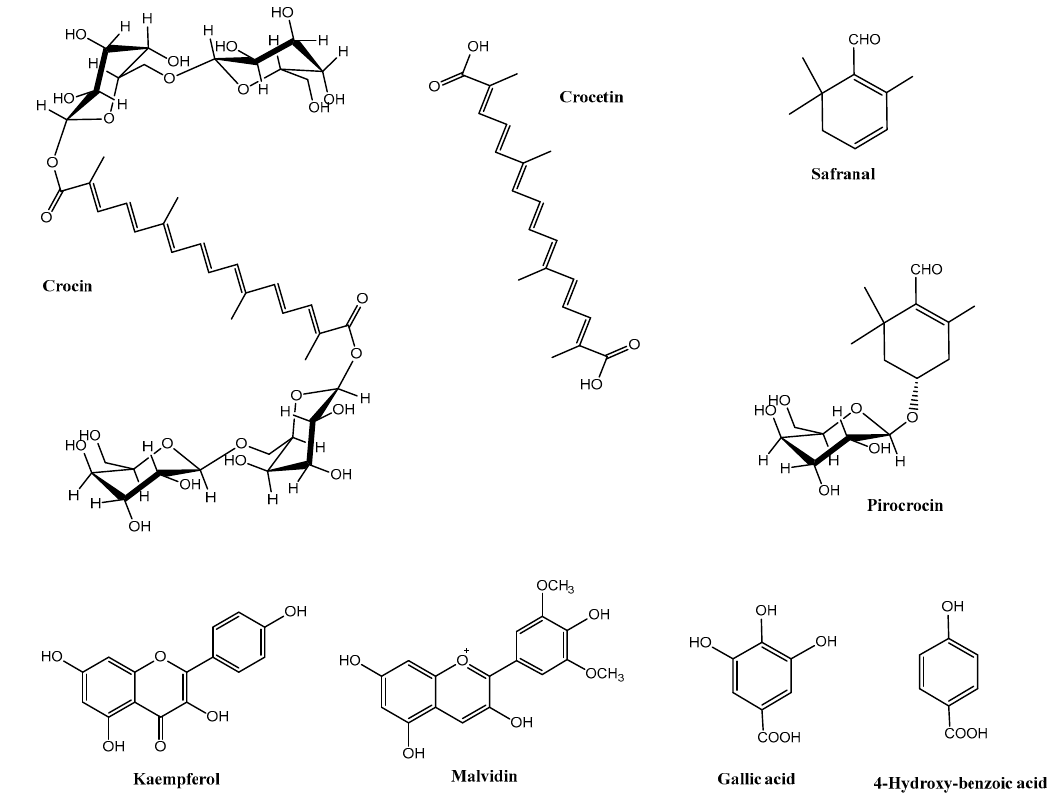
Figure 2. Chemical structure of some of the most representative bioactive compounds present in saffron.